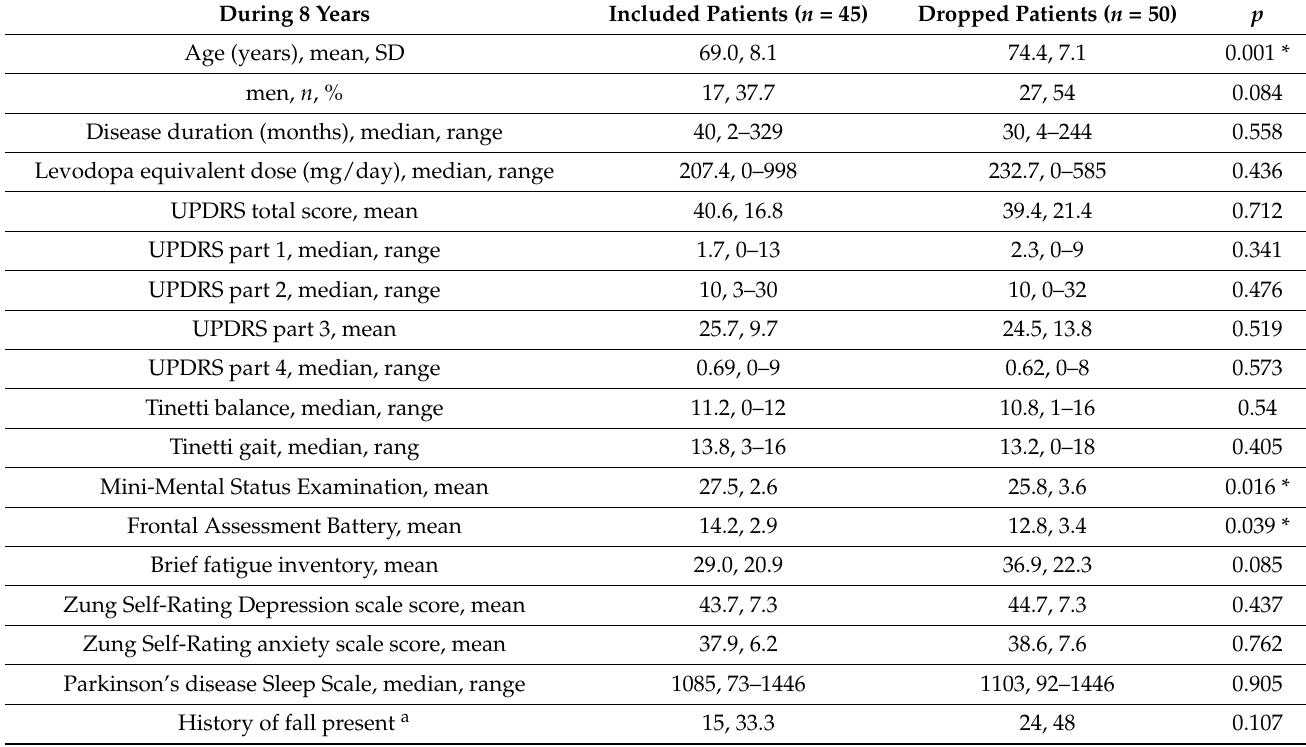
Table 5. Baseline characteristics between patients with Parkinson’s disease who were included in and those who dropped out from the